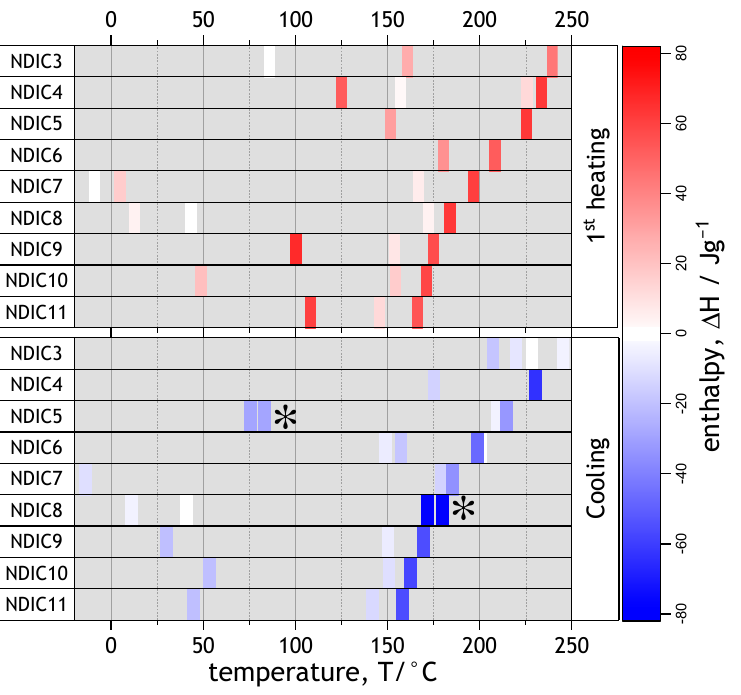
Figure 8. Transition points and corresponding enthalpies of NDIs measured with DSC during heating and cooling runs. Color indicates positive (red) or negative (blue) transition enthalpy. The shade indicates the magnitude of the enthalpy. Multi-peak transitions for which overall enthalpy has been calculated are indicated with asterisks. Original DSC plots are given in the Supplementary Materials.